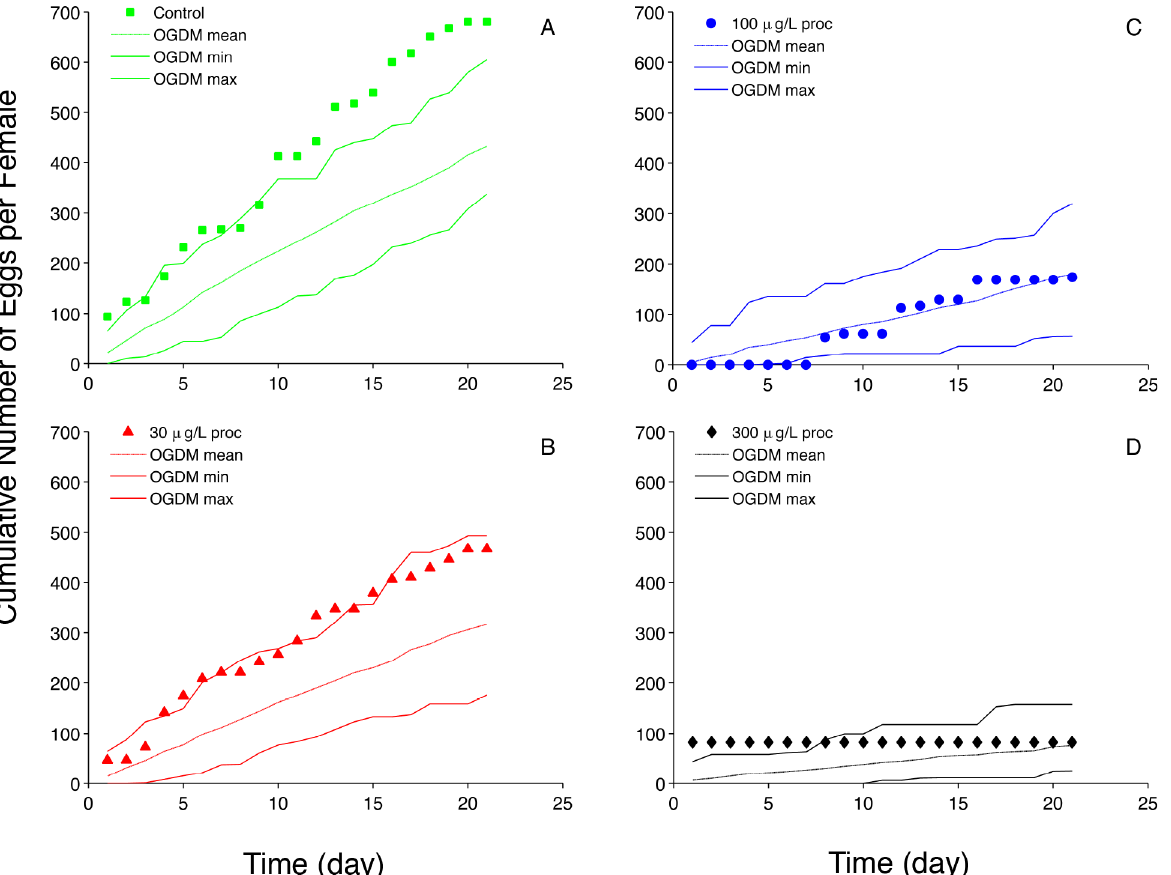
Fig 10. Prochloraz (proc) Average Cumulative Fecundity. (A) control (0 μ g proc (cid:129) L -1 ); (B) 30 μ g proc (cid:129) L -1 ; (C) 100 μ g proc (cid:129) L -1 ; (D) μ g proc (cid:129) L -1 . Filled markers represent experimental data (cumulative fecundity divided by the number of females in a treatment group) [6]; dashed lines represent the mean of 50 cumulative fecundity model predictions; solid lines represent the minimum and maximum values of individual cumulative fecundity out of 50 OGDM model